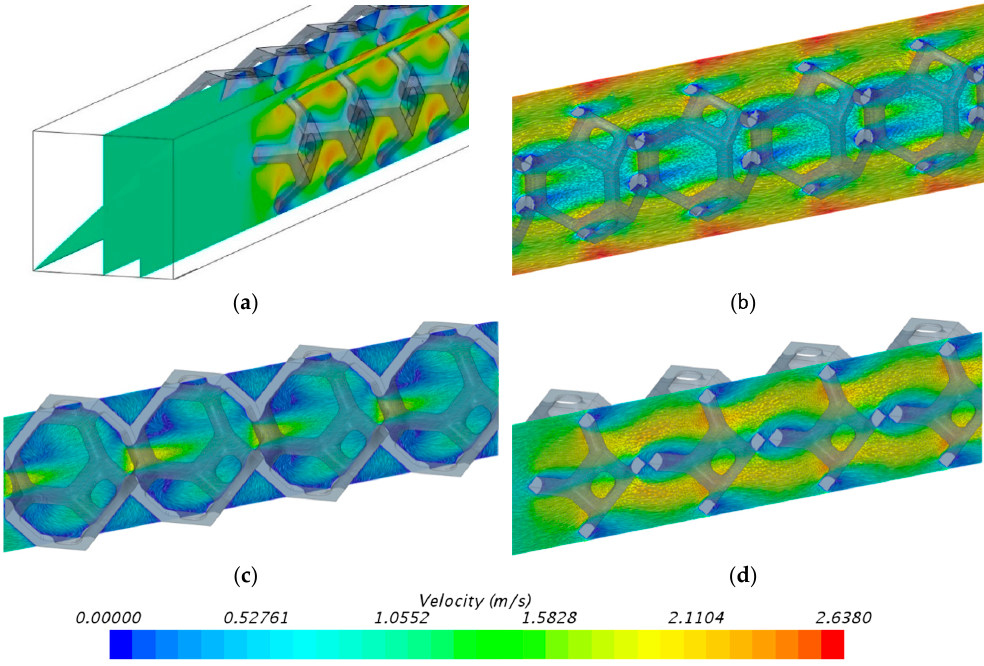
Figure 9. Velocity contours in three planes: ( a ) Schematic of planes, ( b ) oblique cross section, ( c ) center section, ( d ) x = − 1 mm cross section.